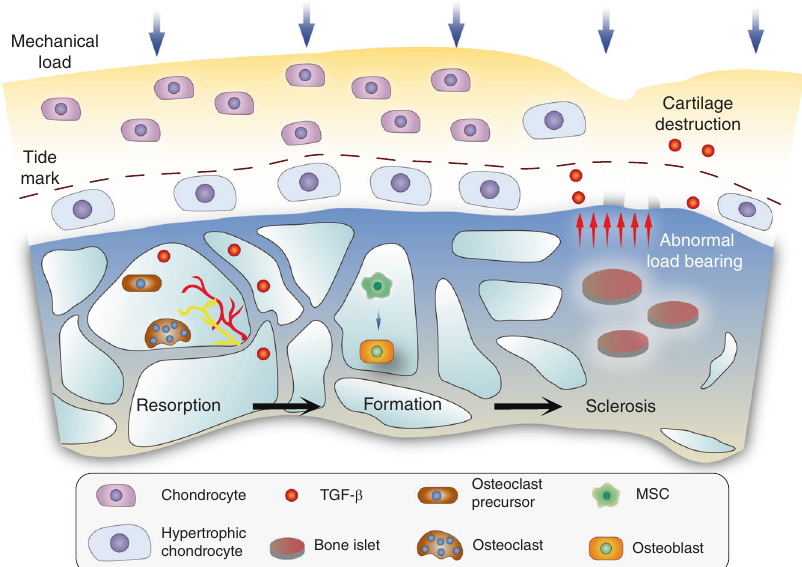
Fig. 1 Schematic diagram of subchondral bone responding to aberrant mechanical loading and subsequent cartilage destruction. In the early stage of knee OA, bone resorption is overactivated, especially in the BML area. Biological factors, such as TGF- β , orchestrate MSC recruitment and bone formation, along with the generation of vessels and nerve fi bers. Osteopetrosis and bone islets can be observed in advanced stages, which induce cartilage degeneration, at least in part, by abnormal load